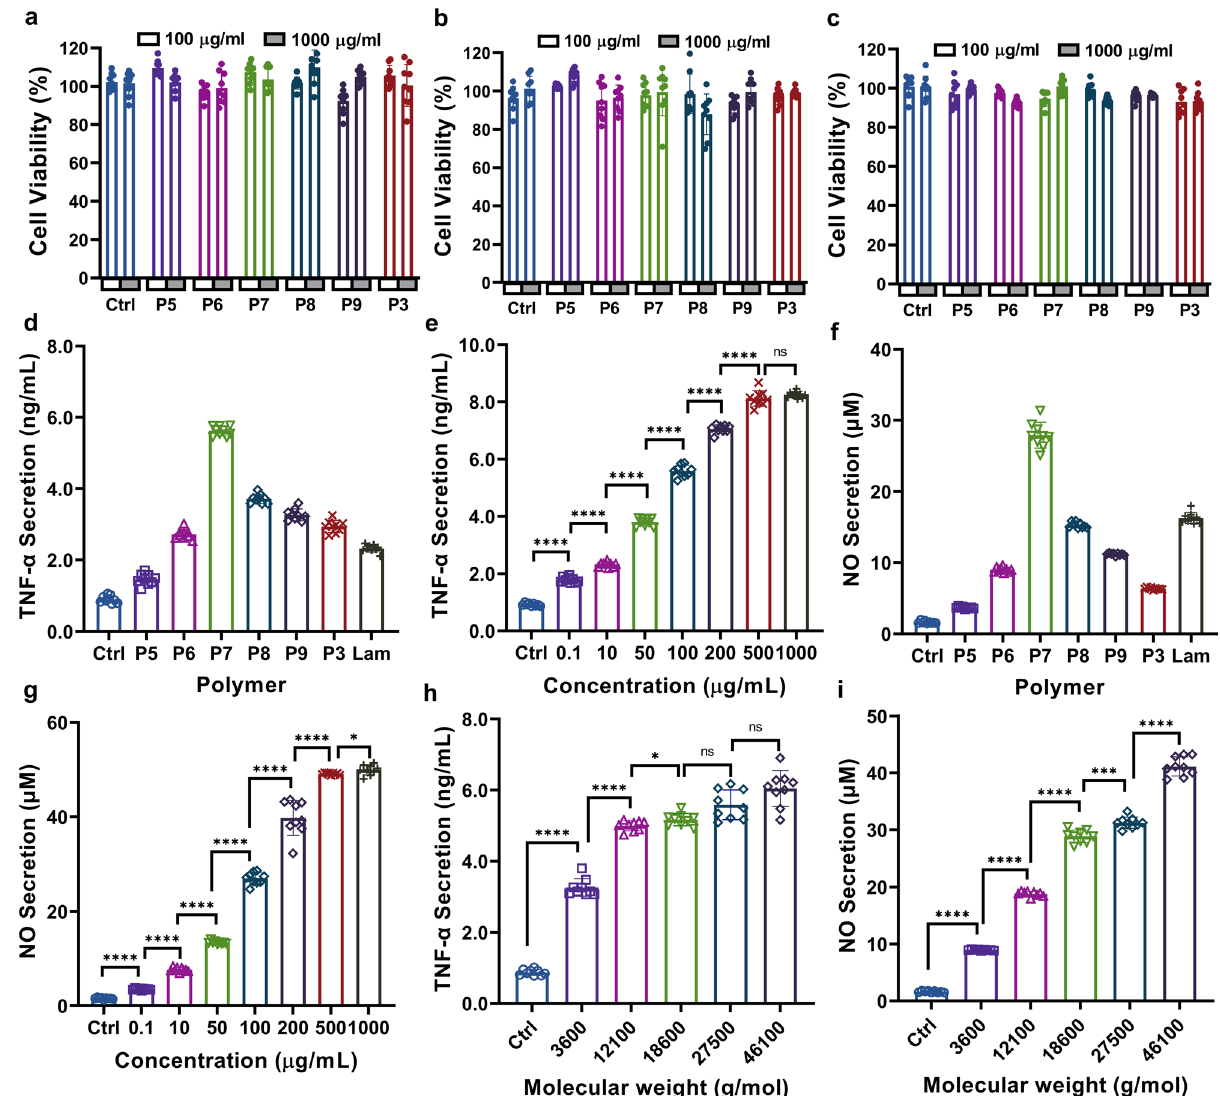
Fig. 5 | Cytotoxicity and immunomodulatory activities of (1 → 6)- β -glucose branched PASs. Cytotoxicity in a RAW264.7; b HepG2; and c Sarcoma − 180 cell lines:37°C,24h. d TNF- α secretion,polymerconcentration:100 μ g/mL,37°C,8h; e Effectofpolymerconcentration(P7,FB30%)onTNF- α secretion:37°C,8h.Two- tailedunpairedttestwereperformedCtrlvs0.1( p <0.0001),0.1vs10( p <0.0001), 10 vs 50 ( p <0.0001), 50 vs 100 ( p <0.0001), 100 vs 200 ( p <0.0001), 200 vs 500 ( p <0.0001), 500 vs 1000 ( p =0.2078); f NO secretion, polymer concentration: 100 μ g/mL, 37°C, 24h; g Effect of polymer concentration (P7, FB 30%) on NO secretion, polymer concentration: 100 μ g/mL, 37°C, 24h. Two-tailed unpaired t test were performed Ctrl vs 0.1 ( p <0.0001), 0.1 vs 10 ( p <0.0001), 10 vs 50 ( p <0.0001), 50 vs 100 ( p <0.0001), 100 vs 200 ( p <0.0001), 200 vs 500 ( p <0.0001),500vs1000( p =0.0346); h EffectofM n (FB30%)onTNF- α secretion,